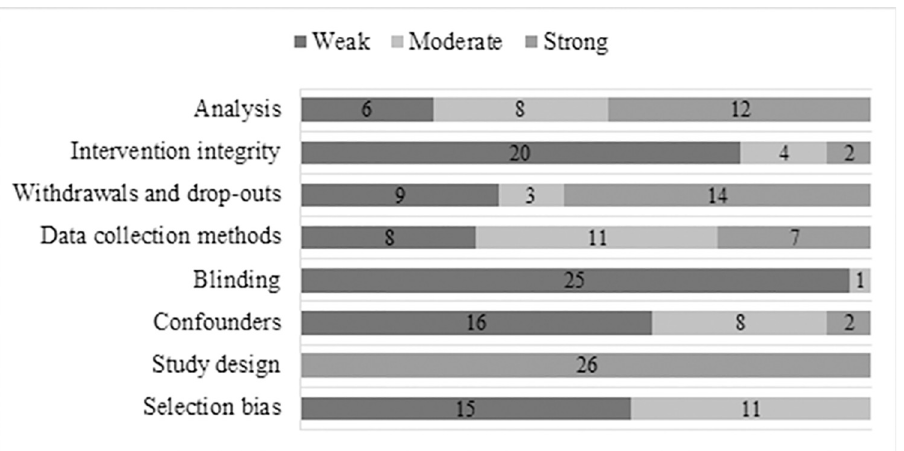
Fig 2. Quality rating of items across included studies.